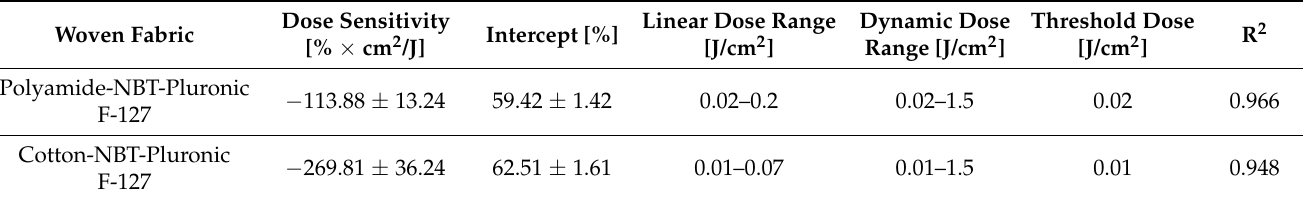
Table 3. Basic characteristics of polyamide and cotton woven fabric printed with NBT-Pluronic F-127 hydrogels and irradiated with UVB radiation. Woven Fabric